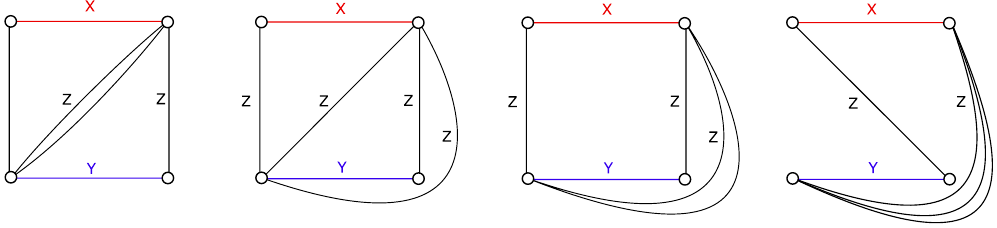
Figure 7 . Planar skeleton diagrams at tree level of the correlator hO 1 O 2 O 3 O 4 i